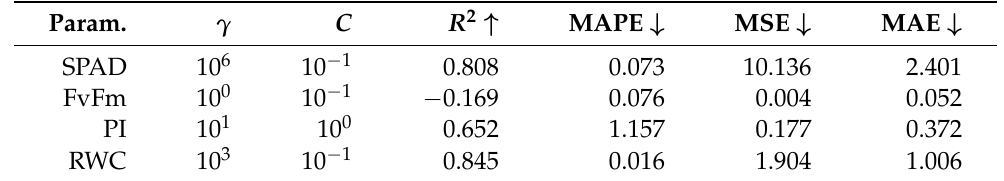
Table 8. The results elaborated using a Support Vector Machine with the hyperparameters optimized for each parameter separately. We indicate if the metric should be minimized ( ↓ ) or maximized ( ↑ ).